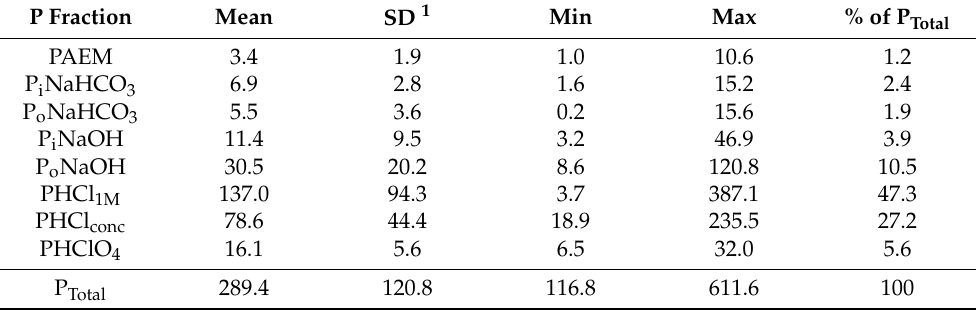
Table 3. Phosphorus fractions (mg · kg − 1 ) in the studied